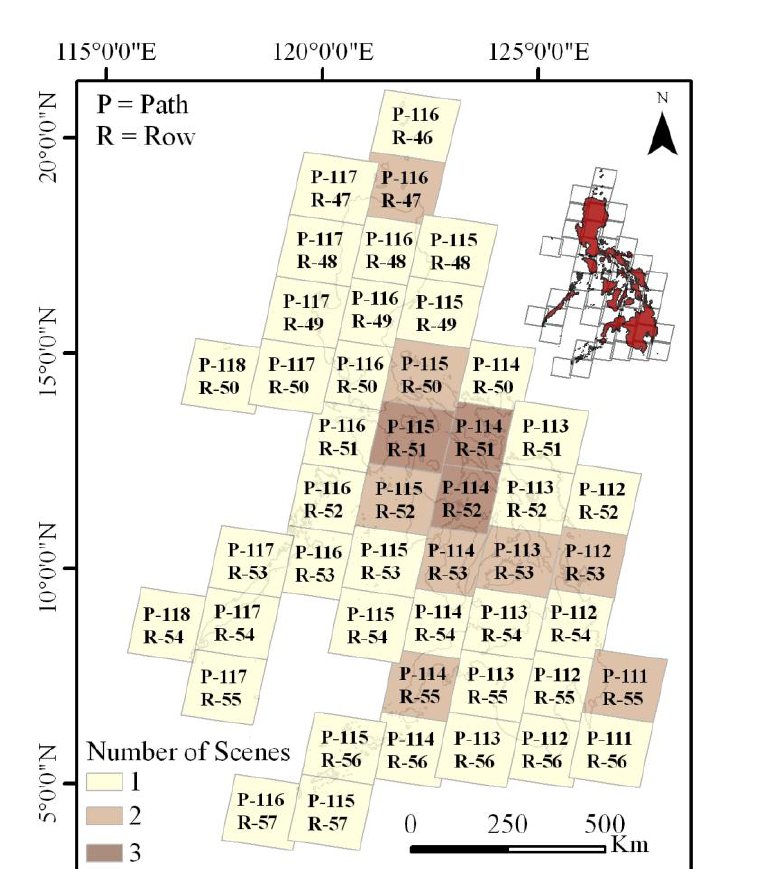
Figure 2. Number of Landsat scenes required for cloud-free classification per path and